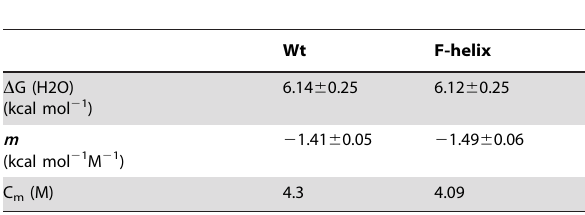
Table 1. Thermodynamic parameters from urea denaturation.